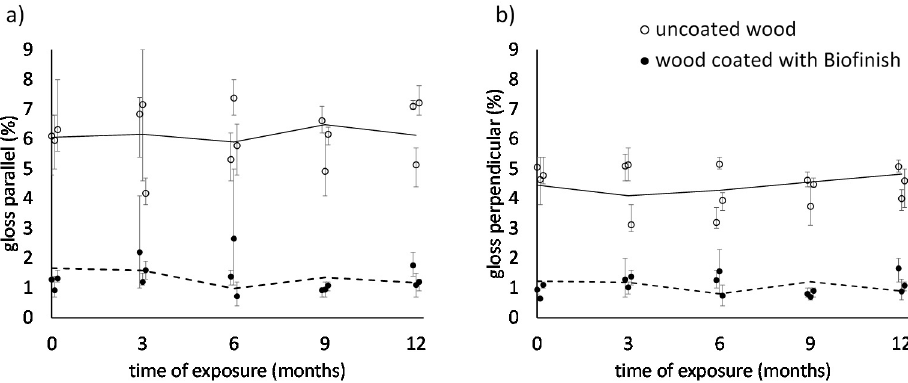
Figure 4. Gloss changes of uncoated Scots pine and wood coated with biofinish as a function of exposure time. Note: Error bars correspond to the range (minimum–maximum) of the results observed: ( a ) gloss parallel, ( b ) gloss perpendicular.